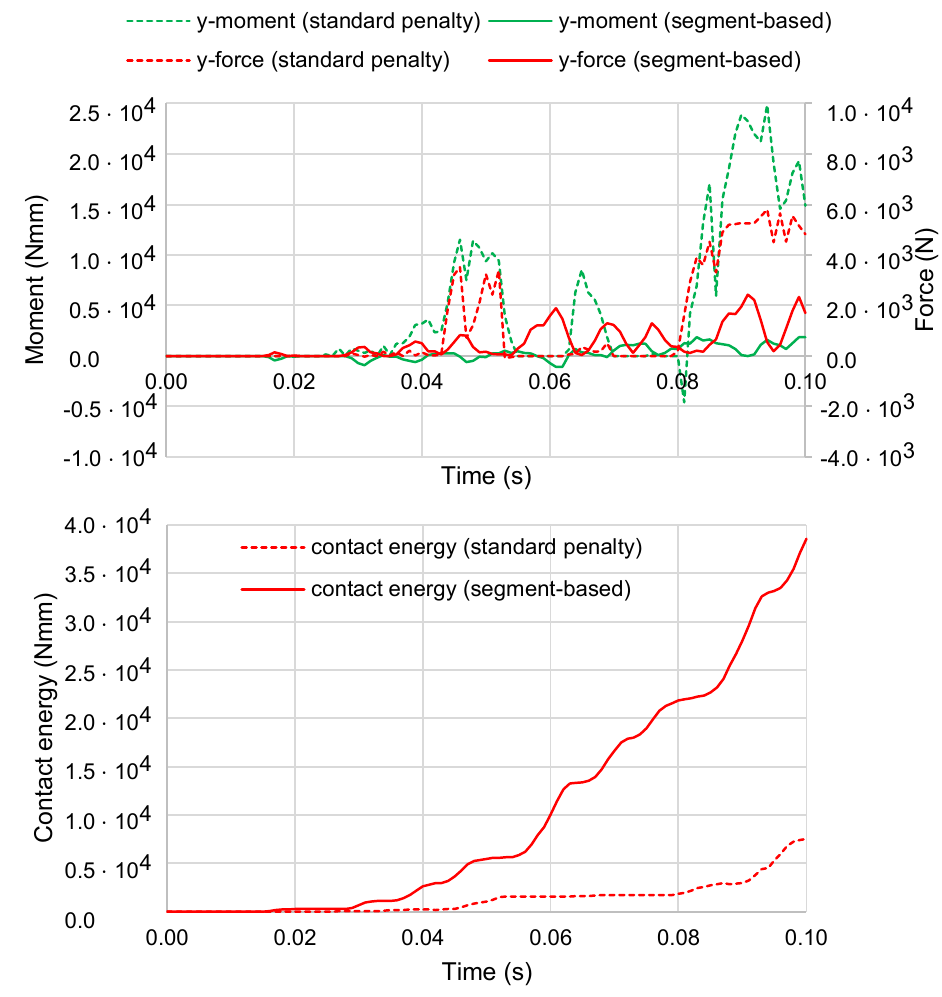
Figure 6. Comparison of contact energies, y-contact forces, and y-contact moments between the standard and segment-based contact penalty formulation for forming the adaptive joining element.